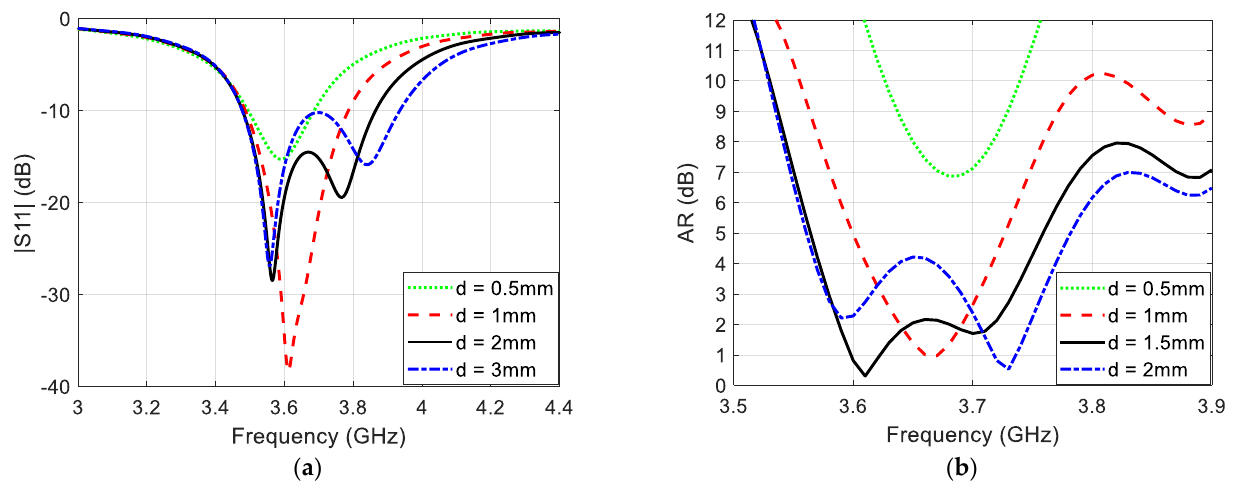
Figure 2. ( a ) Reflection coefficient and ( b ) broadside AR of the proposed microstrip antenna at 𝑊𝑠 = 2 𝑚𝑚 and different values of 𝑑 .